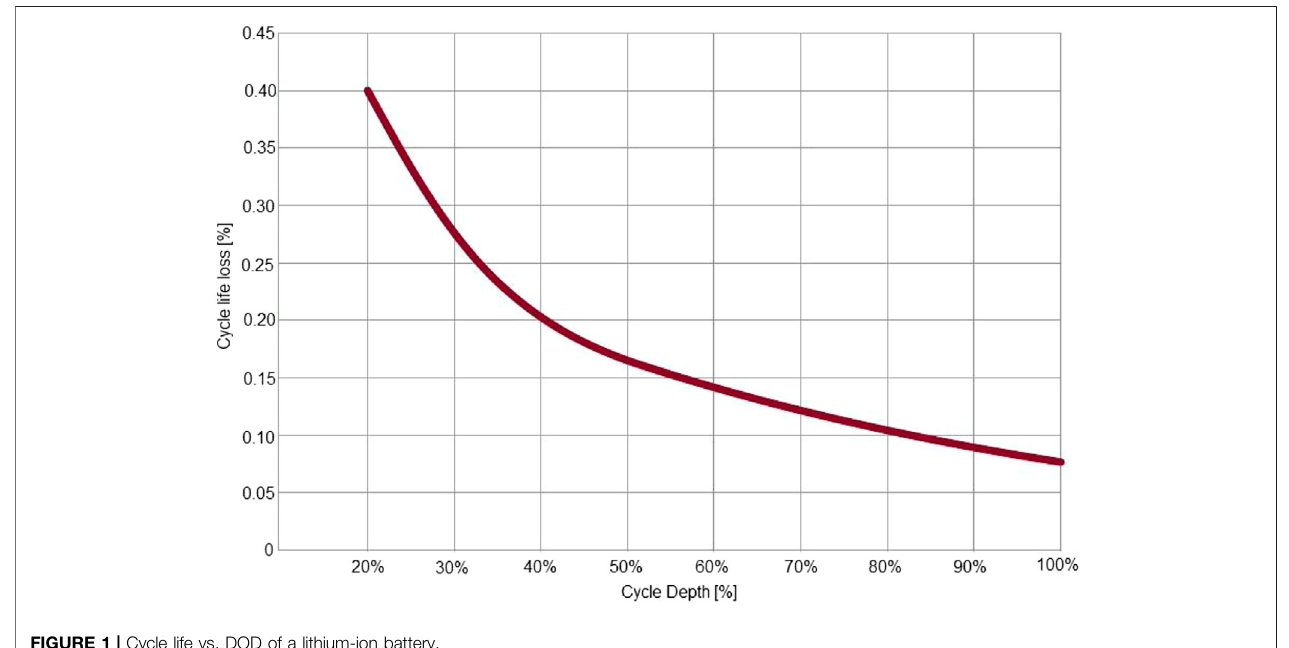
FIGURE 1 | Cycle life vs. DOD of a lithium-ion